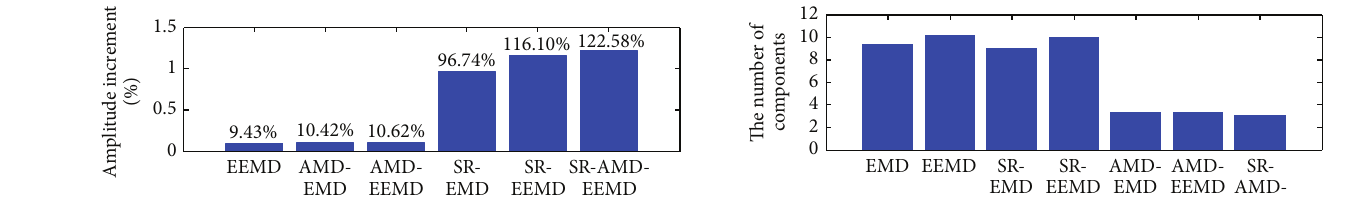
Figure 11: The column chart of percentage increase.